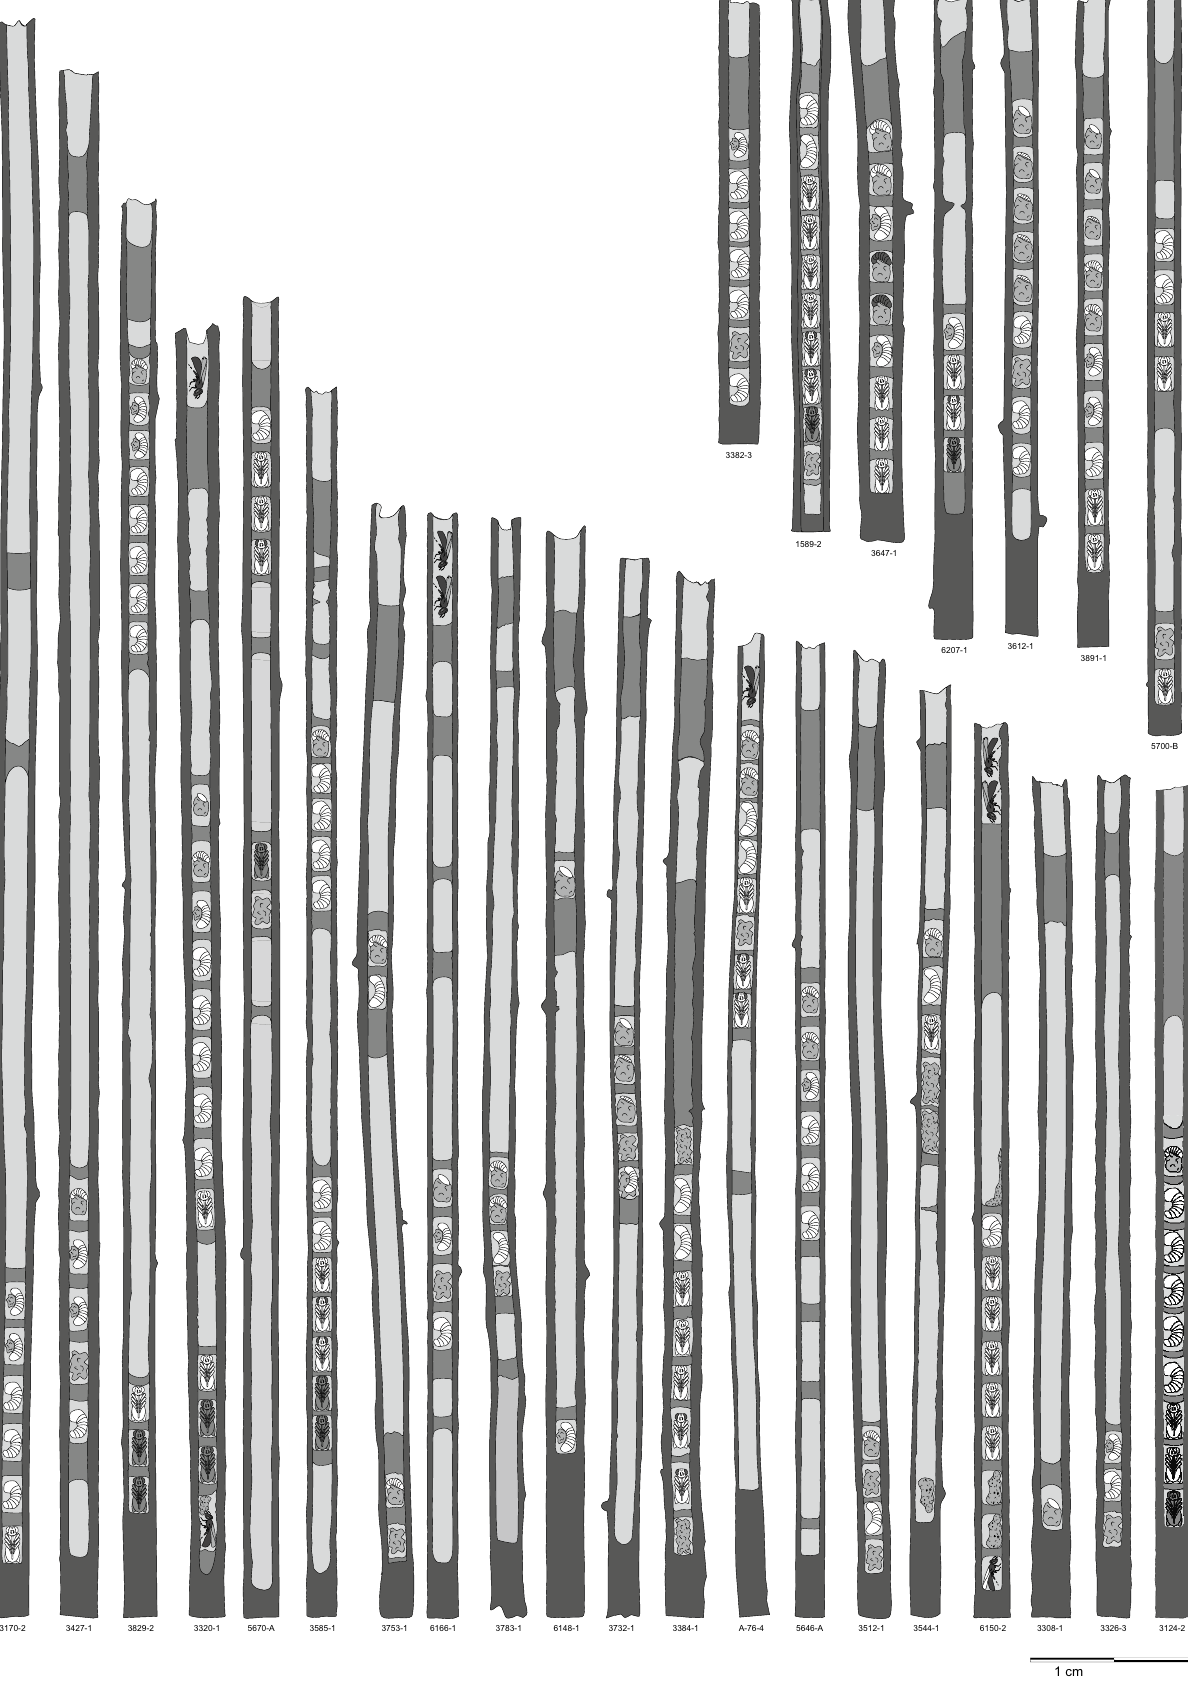
Figure 3. Examples of nests structure of full brood nests of C. nigrolabiata. Pictures of all nests are based on real dissected